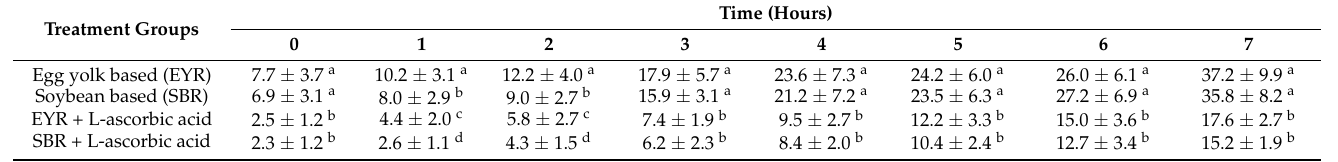
Table 5. Morphological defects (%) of turkey spermatozoa during 7 h of storage at ambient temperature.